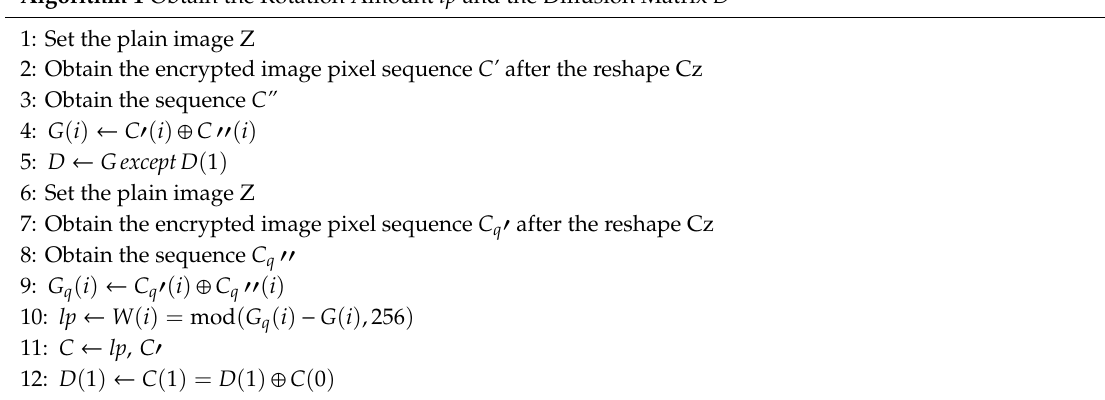
Algorithm 1 Obtain the Rotation Amount lp and the Di ff usion Matrix